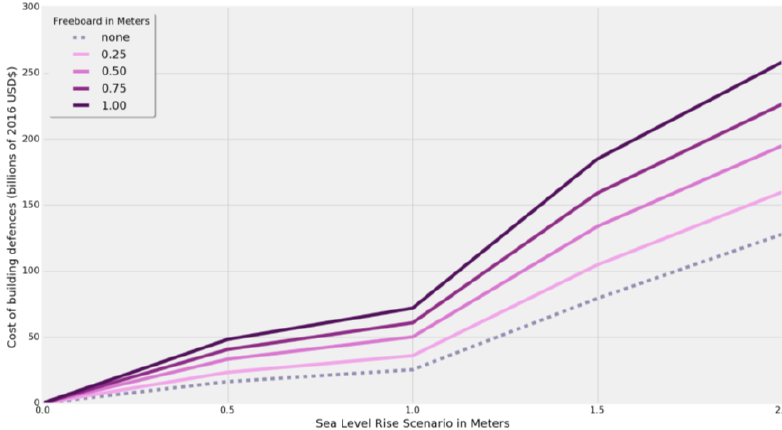
Figure 9. Figure showing the impact of different freeboard heights on the total cost for Shoreline B in billions of 2016 USD$. This calculation is based on Approach #3.